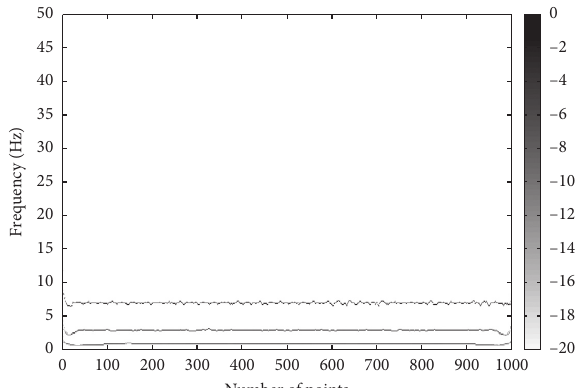
Figure 10: Hilbert–Huang plot